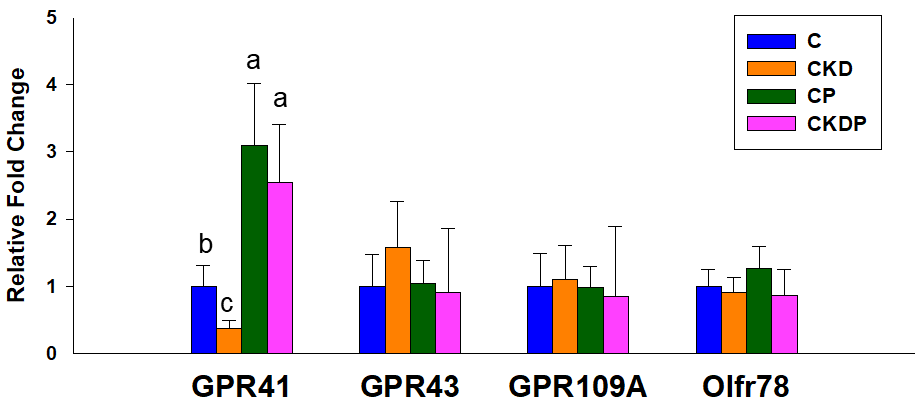
Figure 3. Effect of maternal chronic kidney disease (CKD) and propionate supplementation on the short-chain fatty acid receptor G protein-coupled receptor 41 (GPR41), GPR43, GPR91, and olfactory receptor 78 (Oflr78) in offspring kidneys at 12 weeks of age. The letters a, b, and c show significant differences between groups ( p < 0.05, one-way ANOVA); N = 7–8/group. C = control; CKD = adenine-treated rats; CP = control rats received propionate; CKDP = adenine-treated rats received propionate.